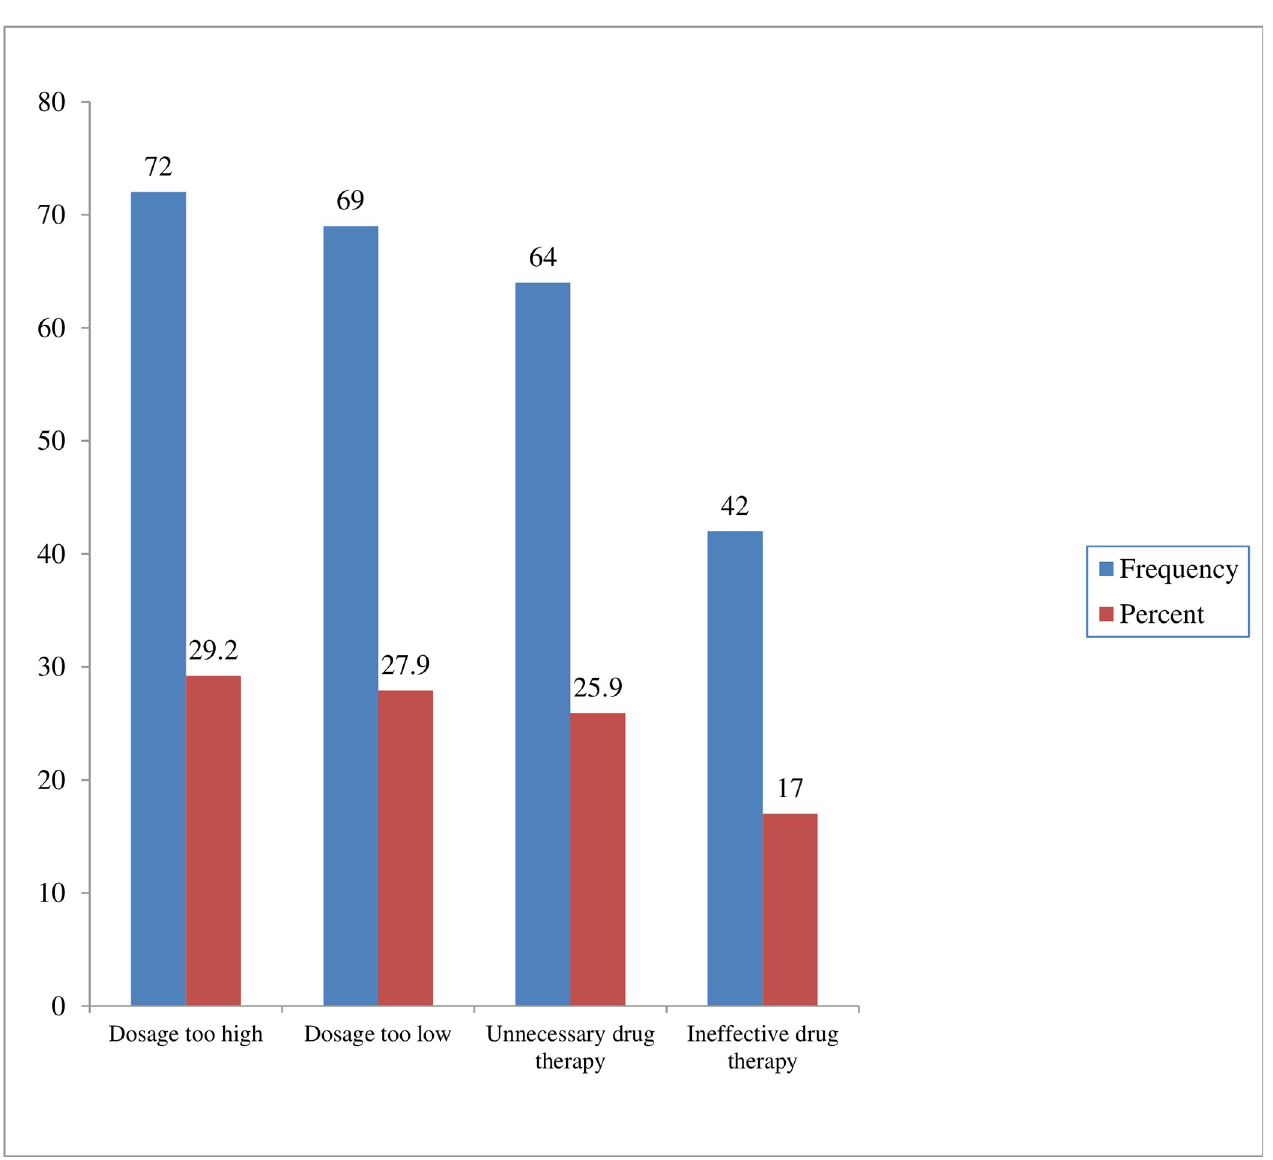
Fig 4. Types of inappropriate anti-diabetic medication therapy among T2DM patients at medical and surgical wards of MRRH, Mbarara, Uganda.